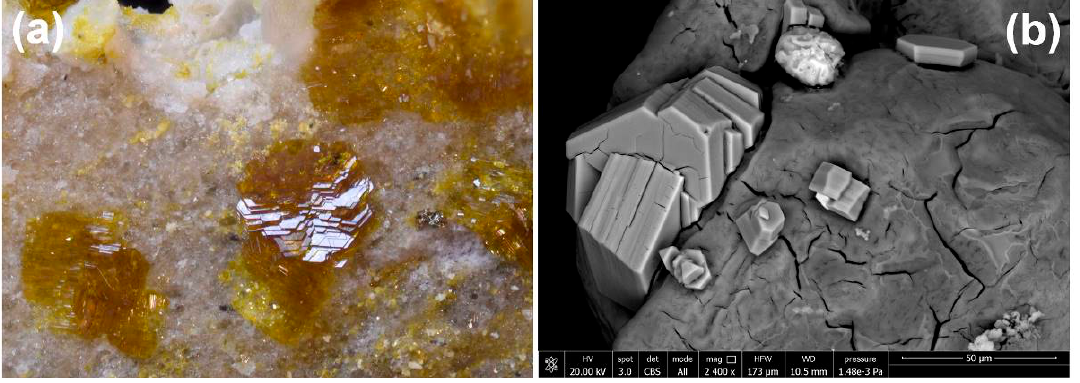
Figure 22. Scordariite, as yellowish tabular pseudohexagonal crystals, up to 1 mm, on microcrystalline alum-(K) ( a ). In ( b ), pseudohexagonal crystals of scordariite grown on alum-(K) with pyrite. Both samples are from the Monte Arsiccio mine.